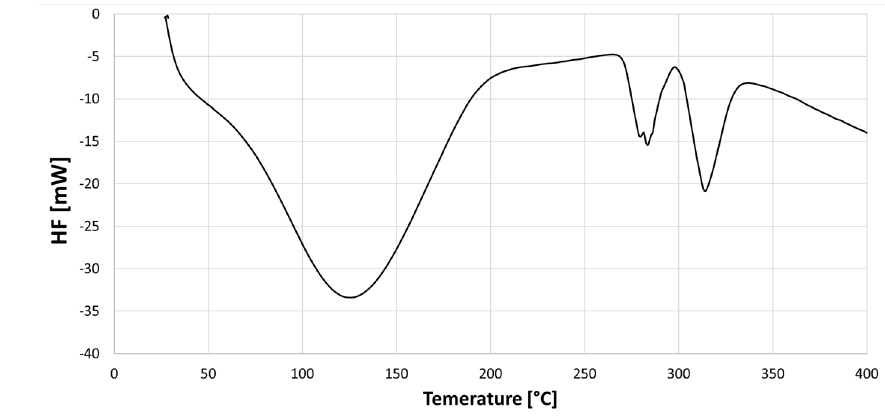
Figure 4. ( a ) Starch granule morphology from optical microscopy at different magnifications, and ( b ) particle size distribution prior to blending ( c ) calorimetric behavior of native maize starch.